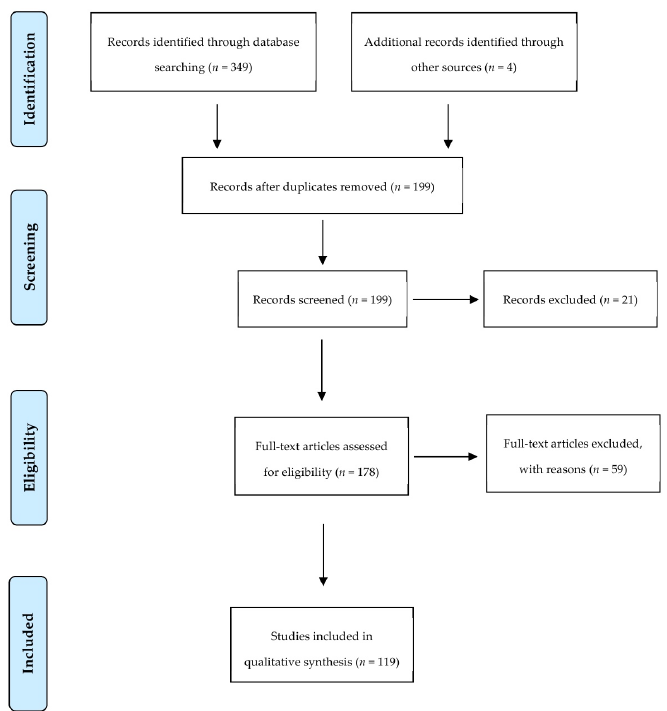
Figure 3 Figure 3. Preferred Reporting Items for Systematic Reviews and Meta-Analysis flow diagram of screened studies.